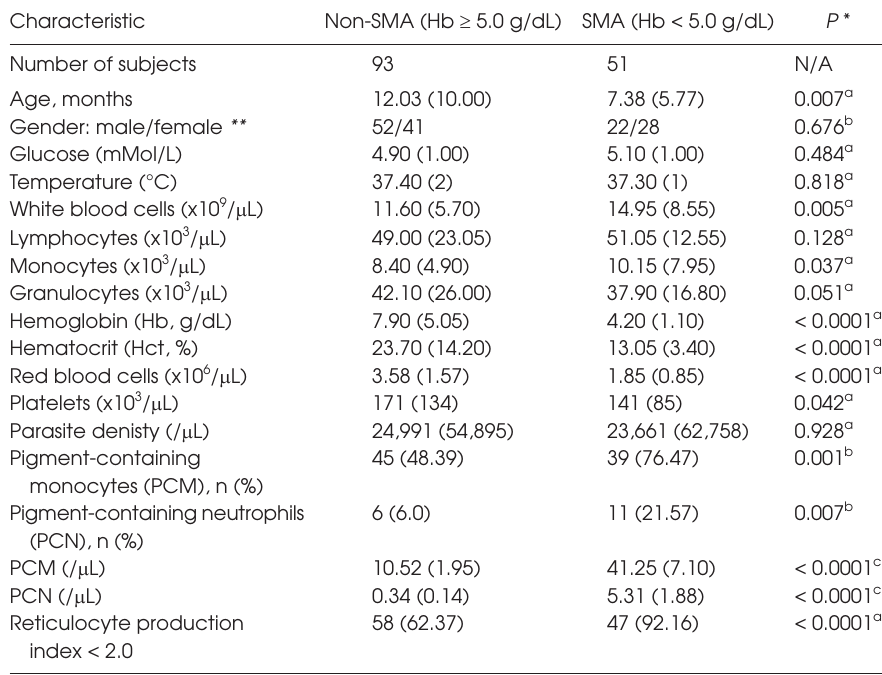
Table 1. Clinical and laboratory characteristics of the study